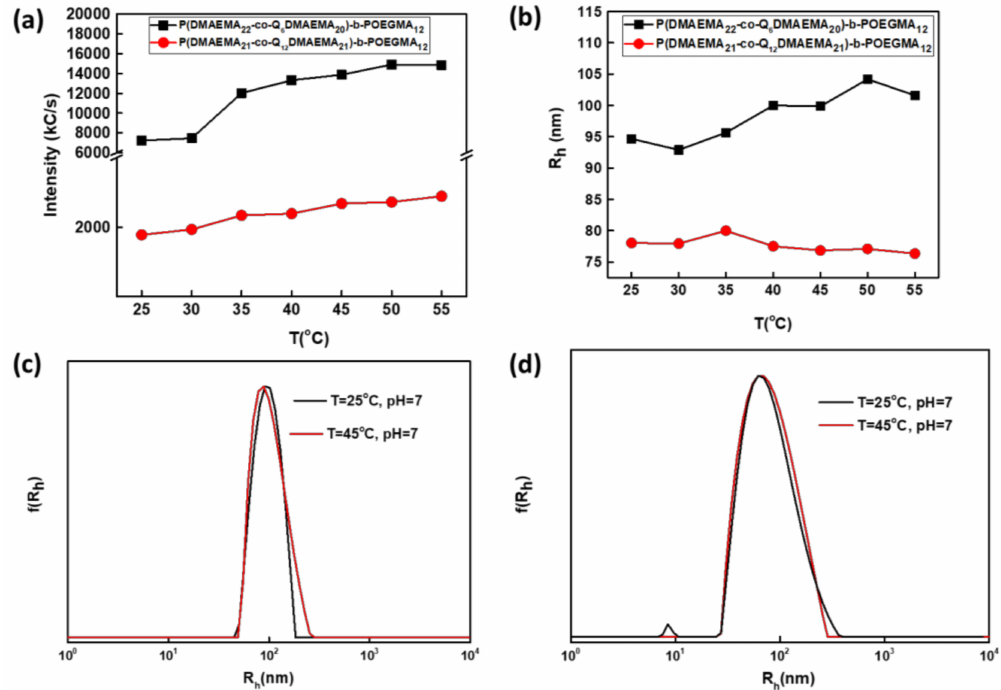
Figure 8. Dependence of ( a ) scattering intensity, ( b ) hydrodynamic radius for the P(DMAEMA 22 -co-Q 6 DMAEMA 20 )- b - POEGMA 12 and P(DMAEMA 21 -co-Q 12 DMAEMA 21 )- b -POEGMA 12 diblock solutions on temperature increase and size distribution from CONTIN obtained at 90 o measurement angle, at T = 25 ◦ C, pH = 7) and at T = 45 ◦ C for ( c ) P(DMAEMA 22 - co-Q 6 DMAEMA 21 )- b -POEGMA 12 and ( d ) P(DMAEMA 21 -co-Q 12 DMAEMA 28 )- b -POEGMA 12